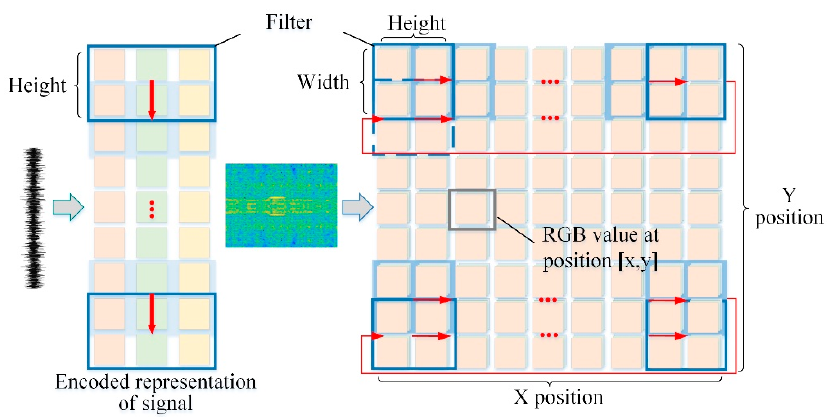
Figure 1. The sliding direction of the filter on a 1DCNN and 2DCNN, respectively.